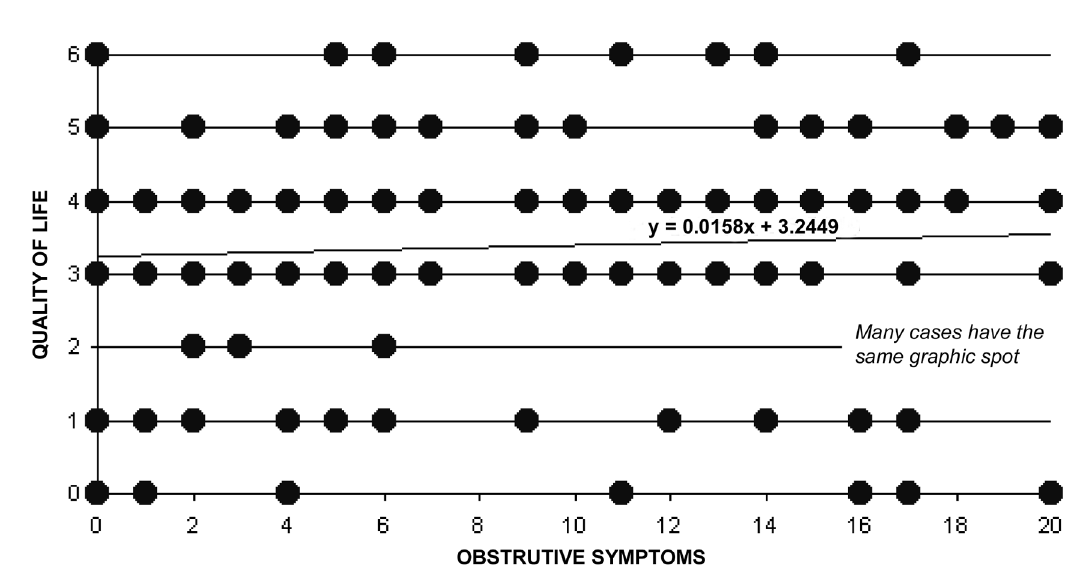
Figure 2 – Correlation between obstructive symptoms and quality of life in 400